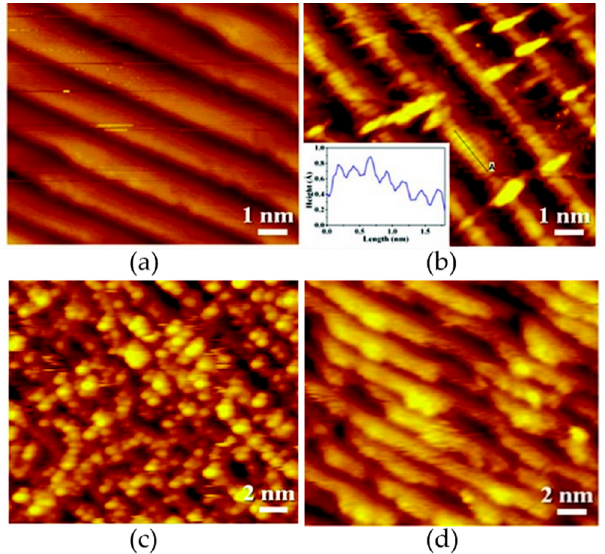
Figure 1. STM images of Pt (557) taken ( a ) under ultra-high-vacuum (UHV) conditions (8 × 10 − 11 Torr); ( b ) in 1 Torr of O 2 for 30 min and ( c ) 2 h after continuous exposure of the clean Pt (557) to O 2 gas; ( d ) after evacuating the high-performance (HP)-STM cell to 10 − 8 Torr for 1.5 h, it can be clearly seen that the clusters degenerate into distinct step edges.